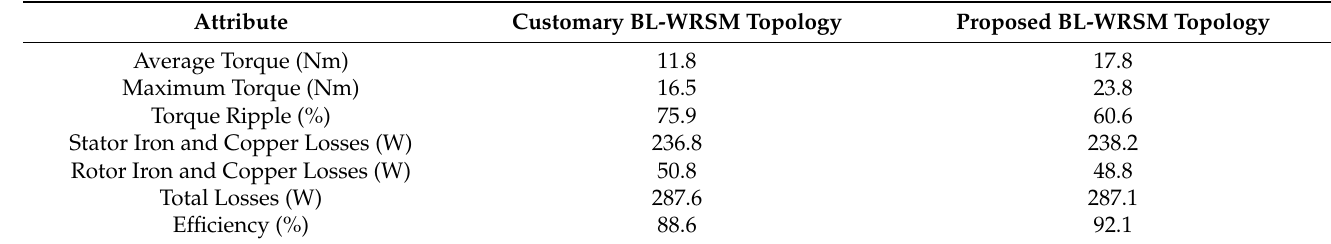
Figure 11. Output torque for the employed machine model using the ( a ) customary, and ( b ) proposed BL-WRSM topologies based on sub-harmonic field-excitation technique. Table 3. Comparative performance